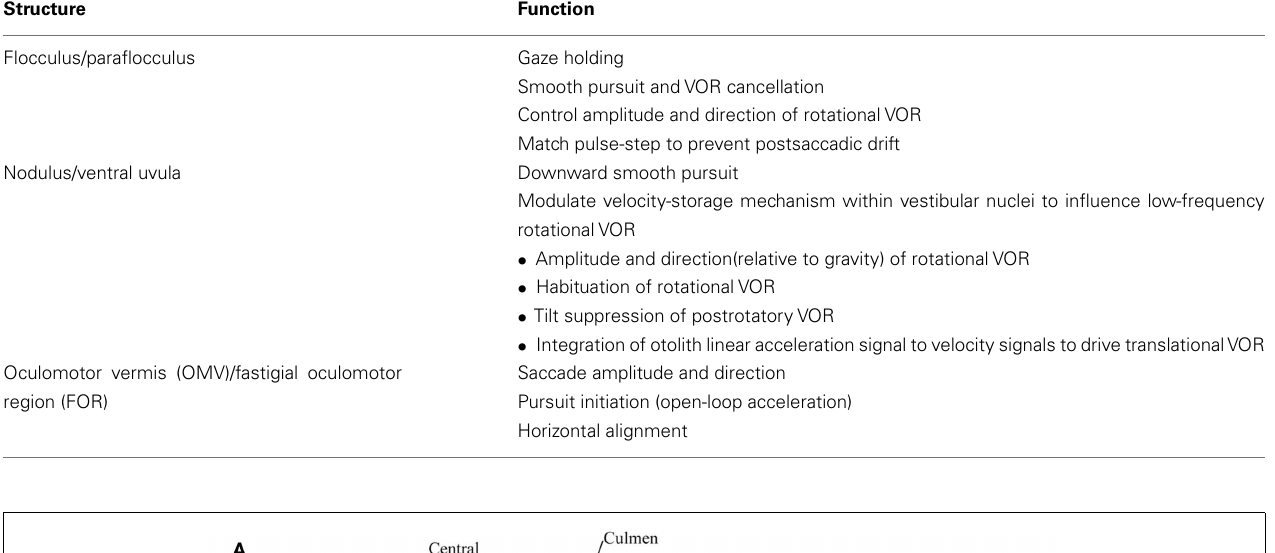
Table 1 |Anatomical localization of ocular motor functions within the cerebellum. Structure